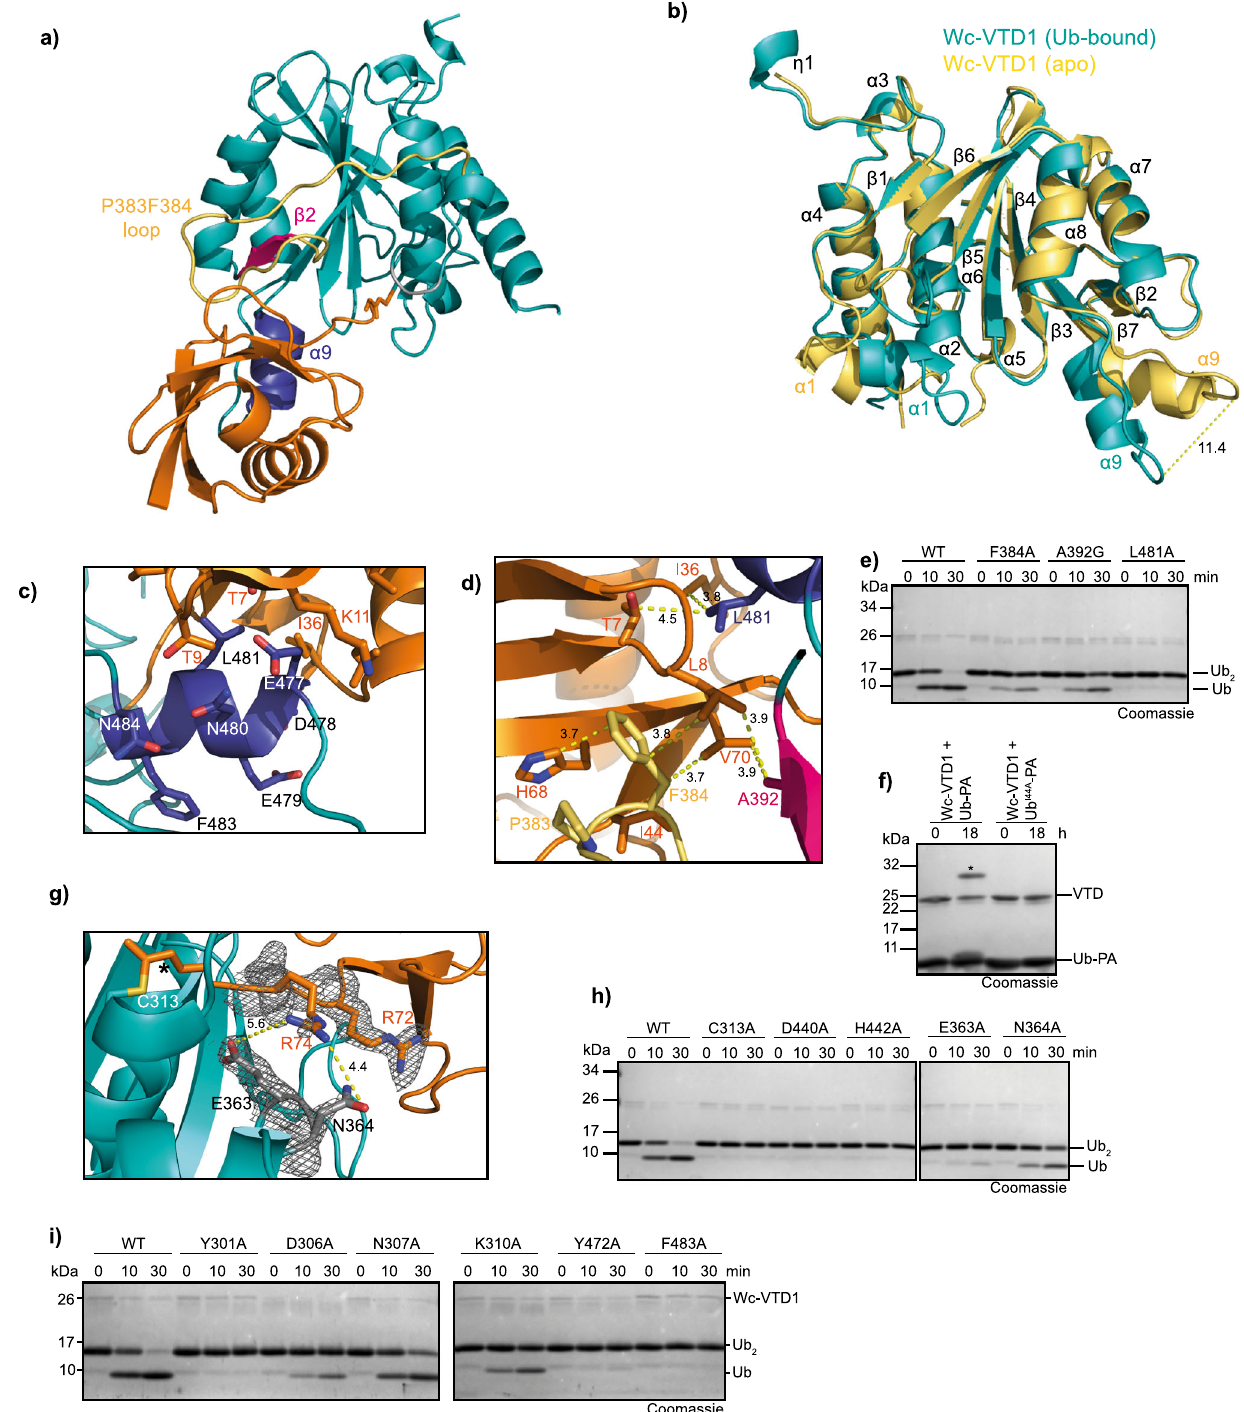
Fig.5|Crystalstructureof WaddliaVTD1 .a CrystalstructureofWc-VTD1(teal)in covalent complex with Ub-PA (orange) in cartoon representation. The α 9 helix is colored blue, β 2 is pink and the P383F384 loop is depicted in yellow. b Structural superposition of apo WcVTD1 (yellow) and ubiquitin-bound Wc-VTD1 (teal). The RMSD is 0.54Å over 205 residues. c Magni fi cation of α 9 interaction with S1 ubi- quitin. Residues of α 9 in Wc-VTD1 are shown as blue sticks and the hydrophobic interaction interface of ubiquitin as orange sticks. d Putative interactions between ubiquitin ’ s Ile44patch (residuesshown asorange sticks) with Wc-VTD1 throughits α 9 (blue), β 2 (pink) and P383F384 loop (yellow). Mutated residues are shown as sticks. e Activity of wildtype Wc-VTD1 (WT) against K6-linked di-ubiquitin com- paredtothebindingmutantsF384A,A392G,L481A. f ReactionofWc-VTD1withthe